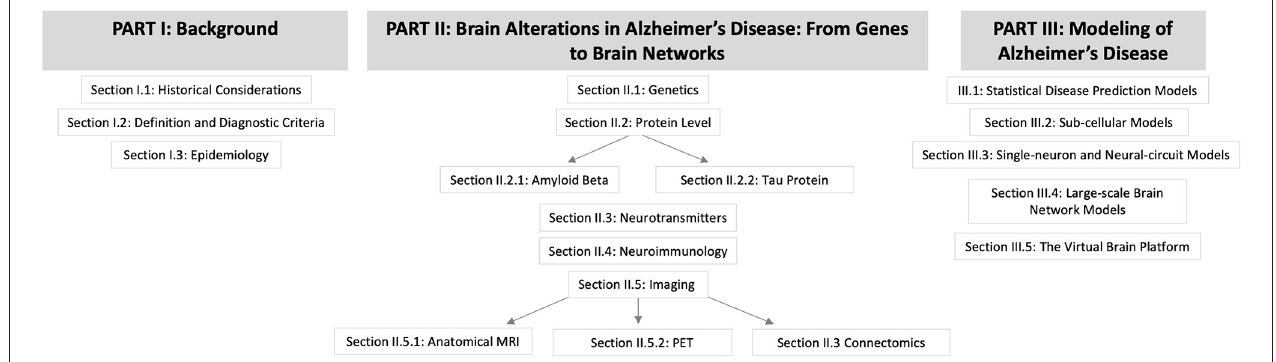
FIGURE 1 | Flowchart for the structure of this